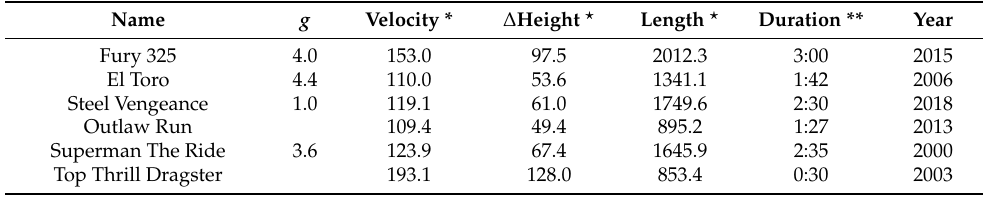
Table A1. Top 50 most popular roller